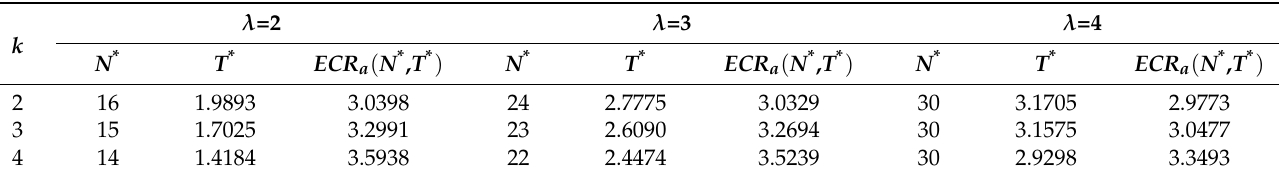
Table 2. The impact of the latter stage warranty on the optimal RNN.